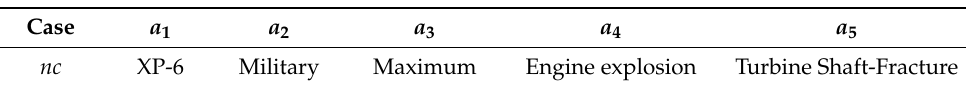
Table 3. A new case for case retrieval.